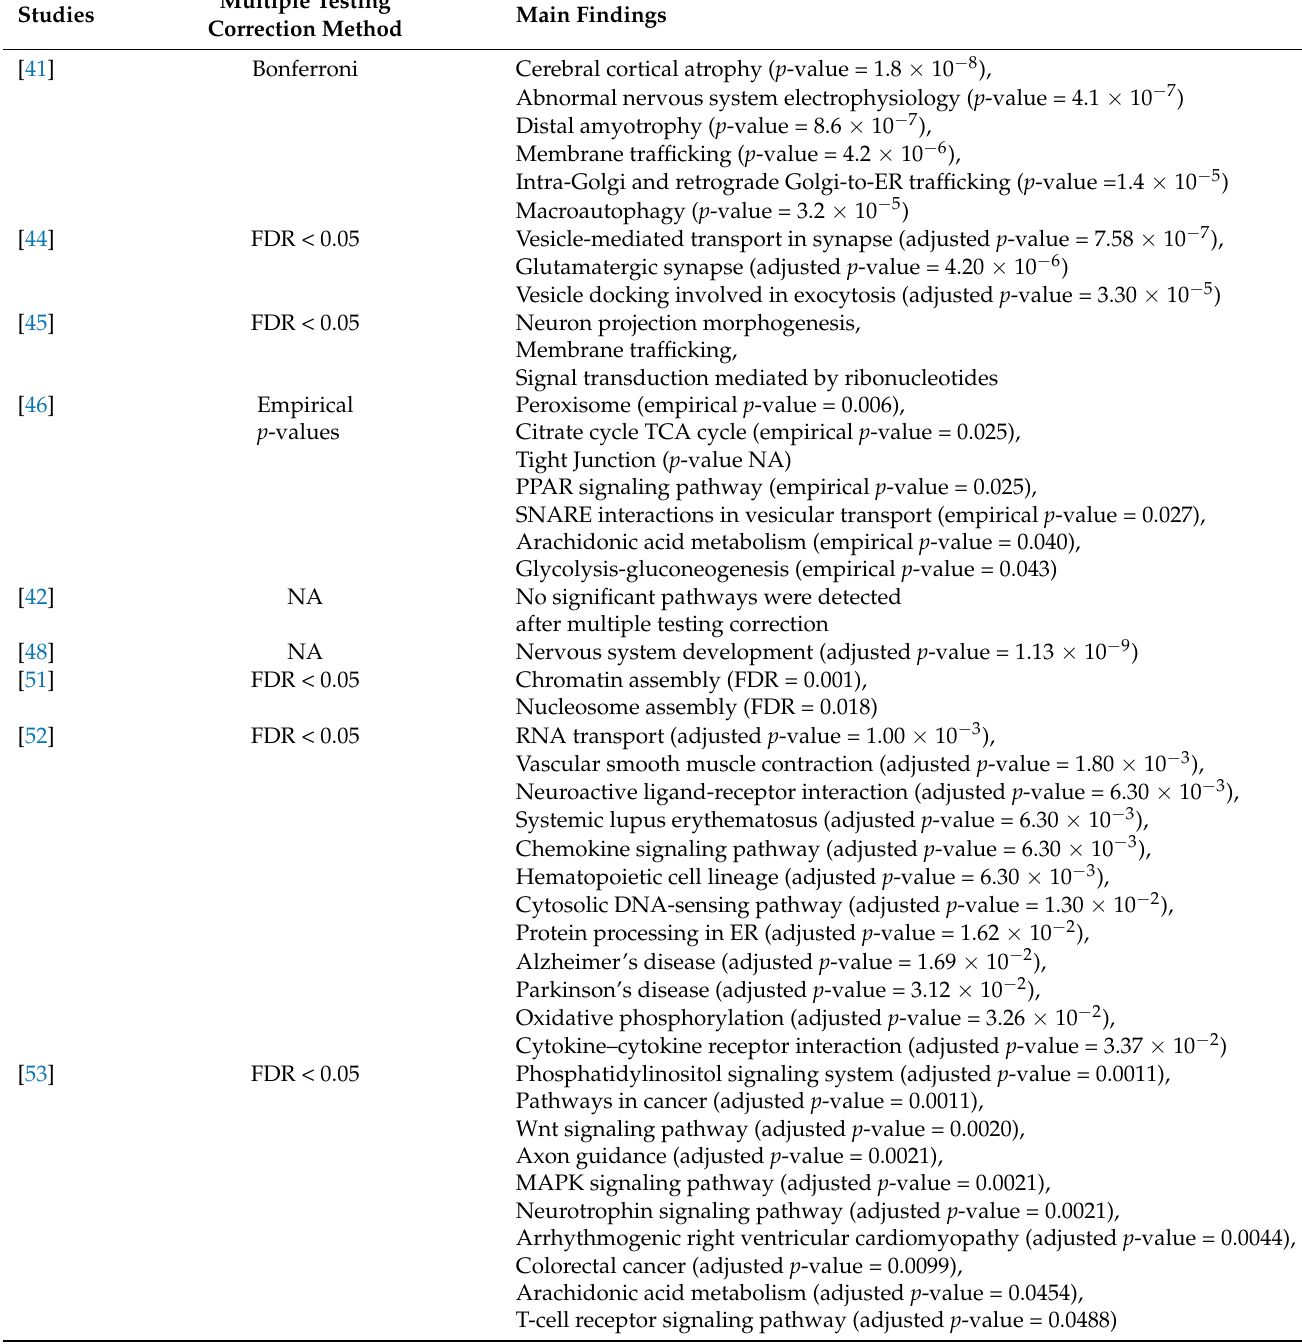
Table 3. Main biological pathways that were discovered by current ALS GWAS-GSA studies. Here, we present the main significant findings of each study, in terms of ALS-associated gene sets with their accompanied p -values (where possible). We also include the chosen multiple testing correction methods and threshold for each study (where available), applied to the final list of significant findings. We note that, for practical purposes, this table does not include the full list of significant results for every study. The studies are sorted by chronological order of publication. ALS: Amyotrophic Lateral Sclerosis, ER: Endoplasmic Reticulum, GSA: Gene-Set Analysis, GWAS: Genome-Wide Association Study, NA: Not